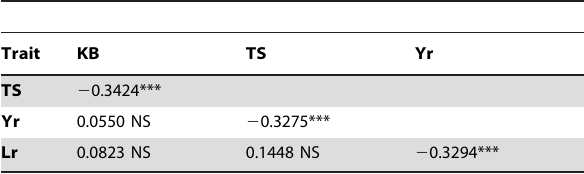
Table 1. Phenotypic correlations among mean score for Karnal bunt (KB), tan spot (TS), yellow rust (Yr), and leaf rust (Lr) diseases.